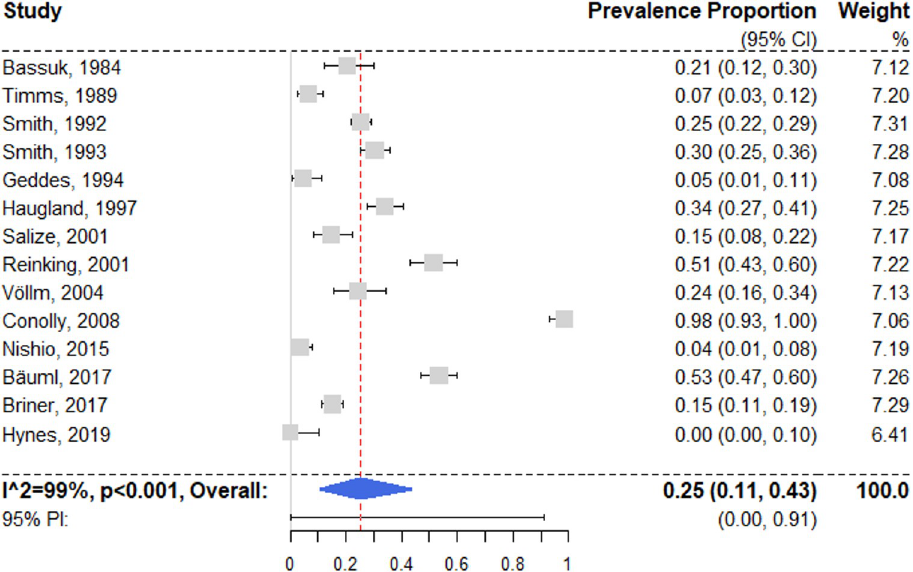
Fig 8. Forest plot of prevalence of personality disorders. AU : Basedonthereferenceslist ; IbelievethefollowingareerrorsinFig 8 : ð 1 Þ Newton ; 1994 shouldbeGeddes ; 1994 ½ 67 �ð 2 Þ Hynes ; 2018 shouldbeHynes ; 2019 ½ 62 � PleasefixtheseerrorsinFig 8 : Asecond (cid:0) bestsolutionwouldbetoequatethesemisidentifiedrefswiththeircorrectreferencenumbersinthefigurelegend : Analytic weights are from random effects meta-analysis. Grey boxes represent study estimates; their size is proportional to the respective analytical weight. Lines through the boxes represent the 95% CIs around the study estimates. The blue diamond represents the mean estimate and its 95% CI. The vertical red dashed line indicates the mean estimate. CI, confidence interval; PI, prediction interval; RE, random